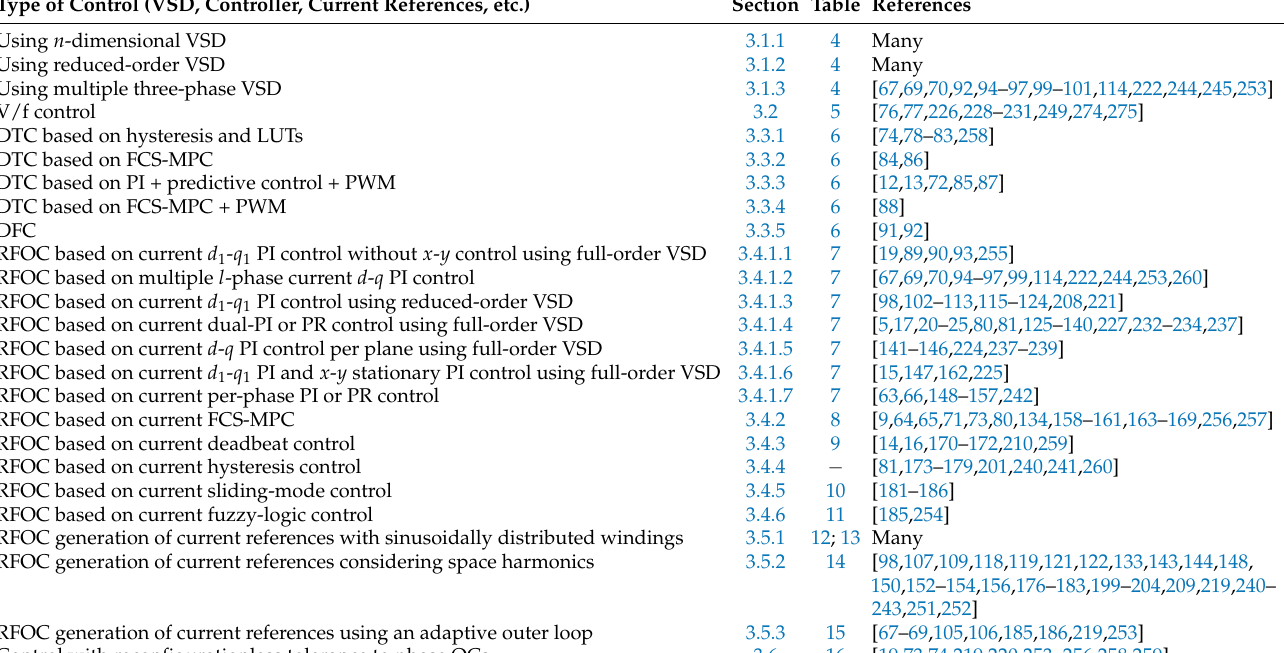
Table 3. Classification of references (and paper sections/tables) about control methods for tolerating phase/switch OCs (Section 3) in multiphase applications in the literature.